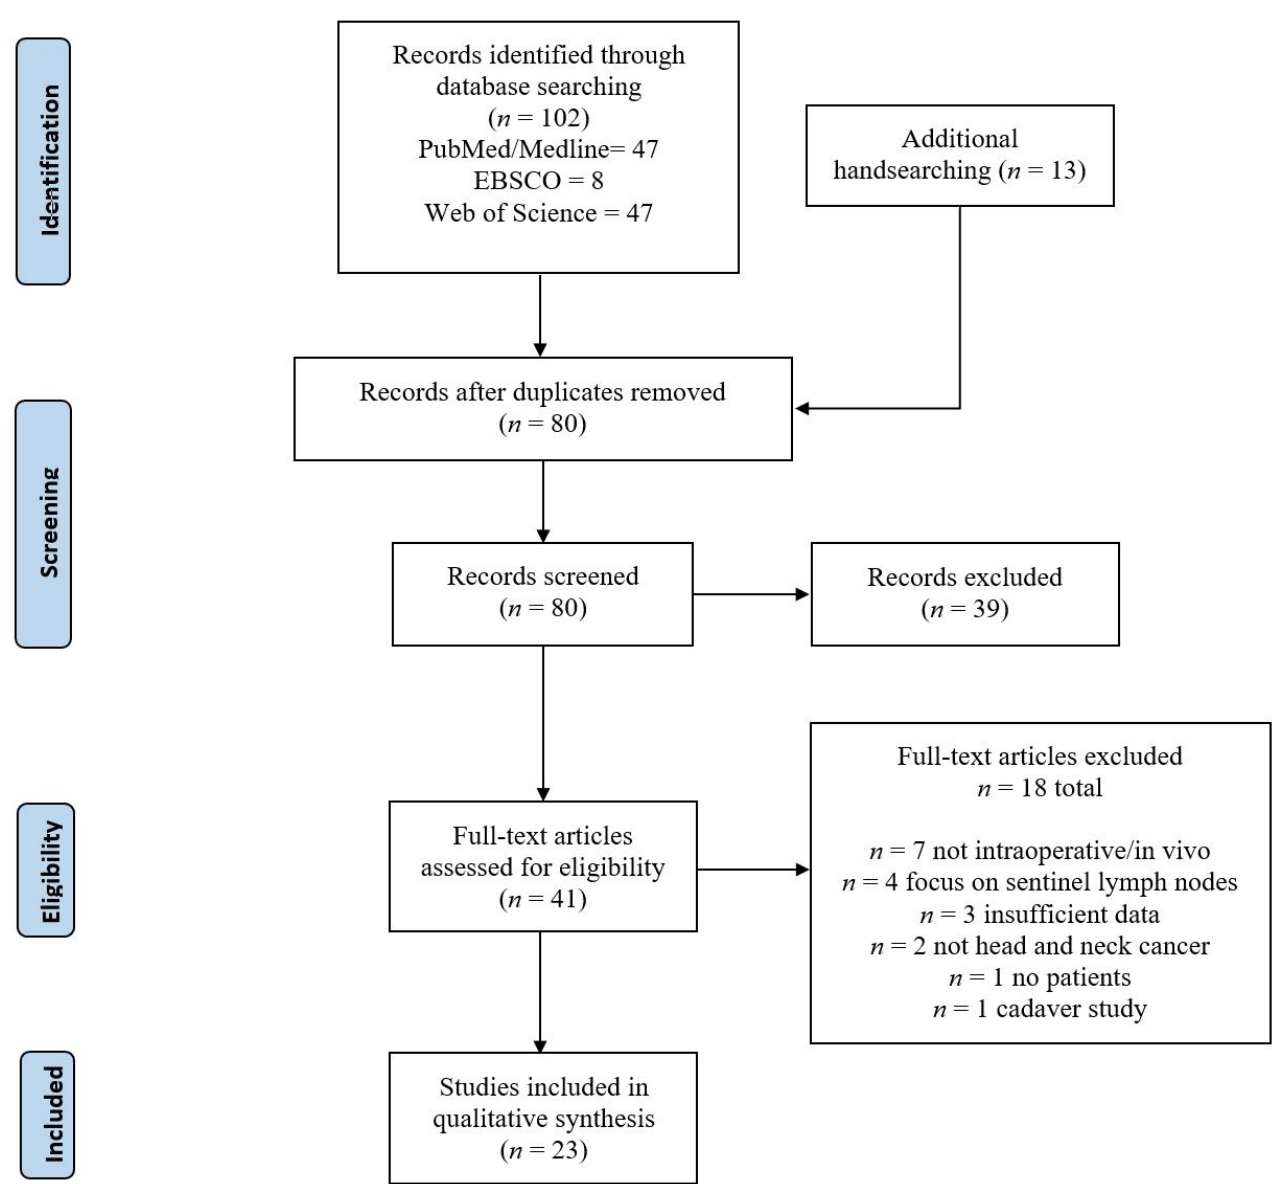
Figure 1. Flow diagram adapted from Preferred Reporting Items for Systematic Reviews and Meta- Analyses (PRISMA) 2020.